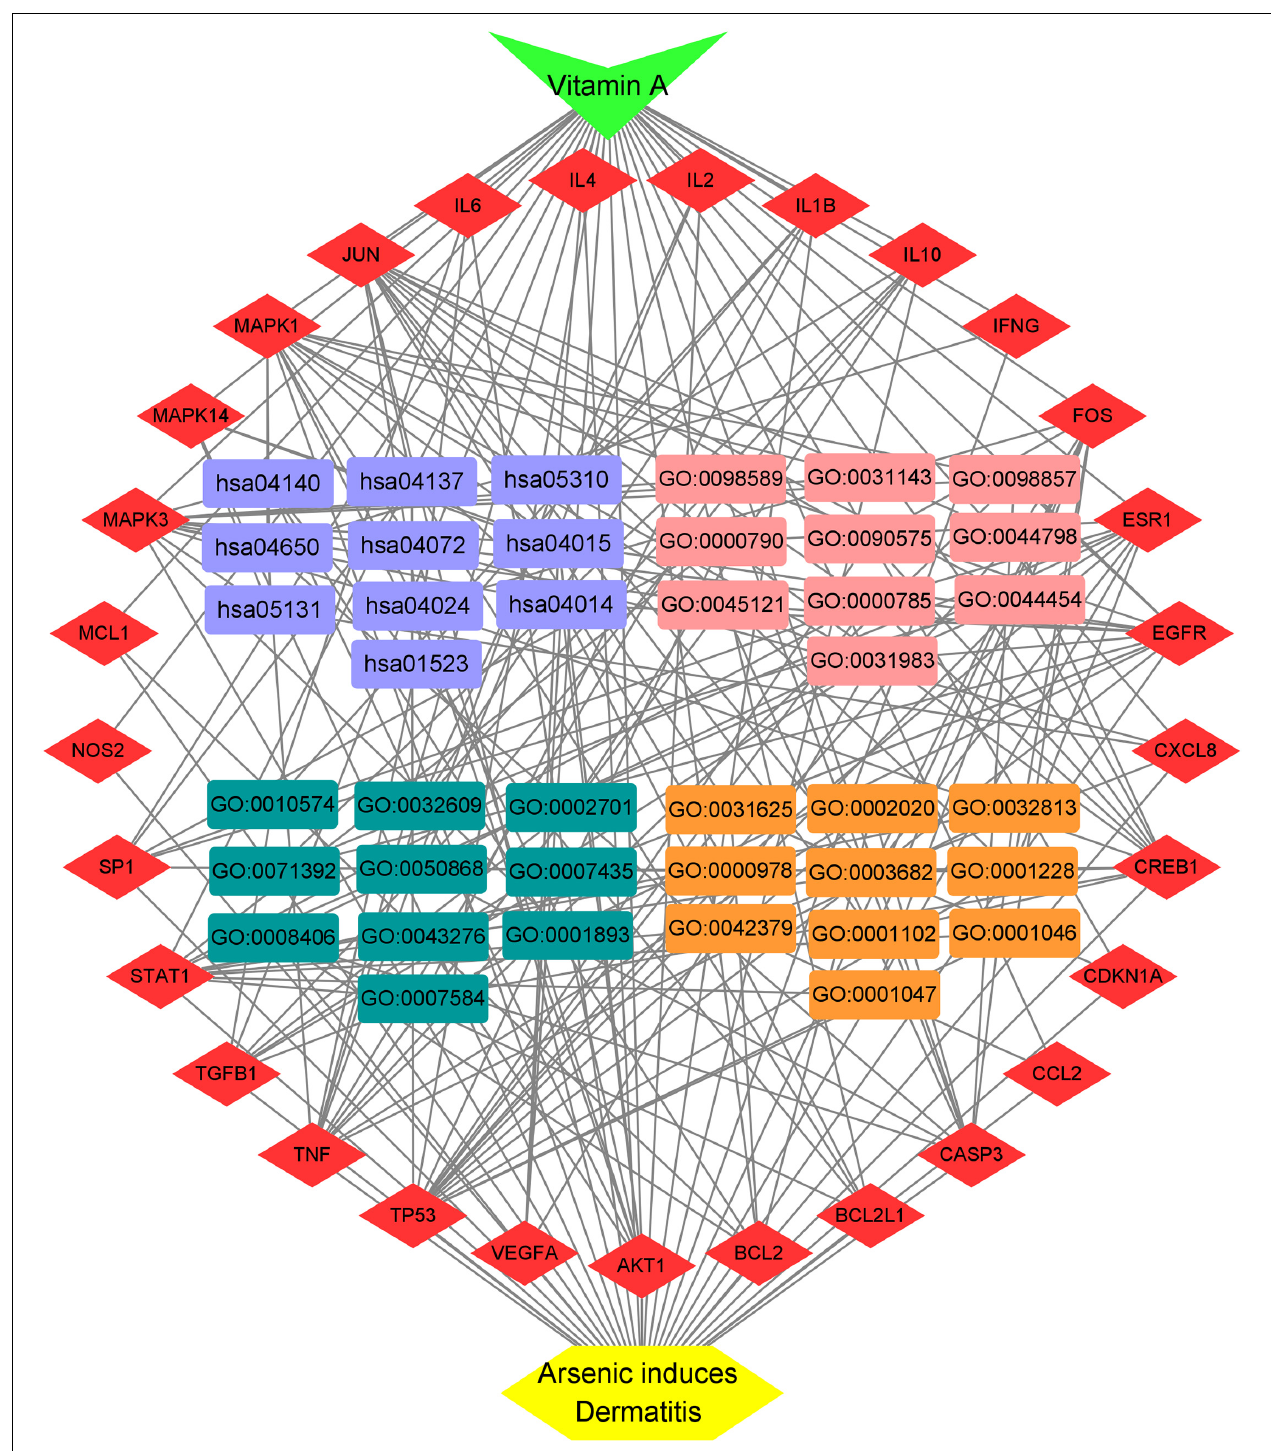
FIGURE 5 | VA-targets-pathways-As-linked dermatitis network characterization.